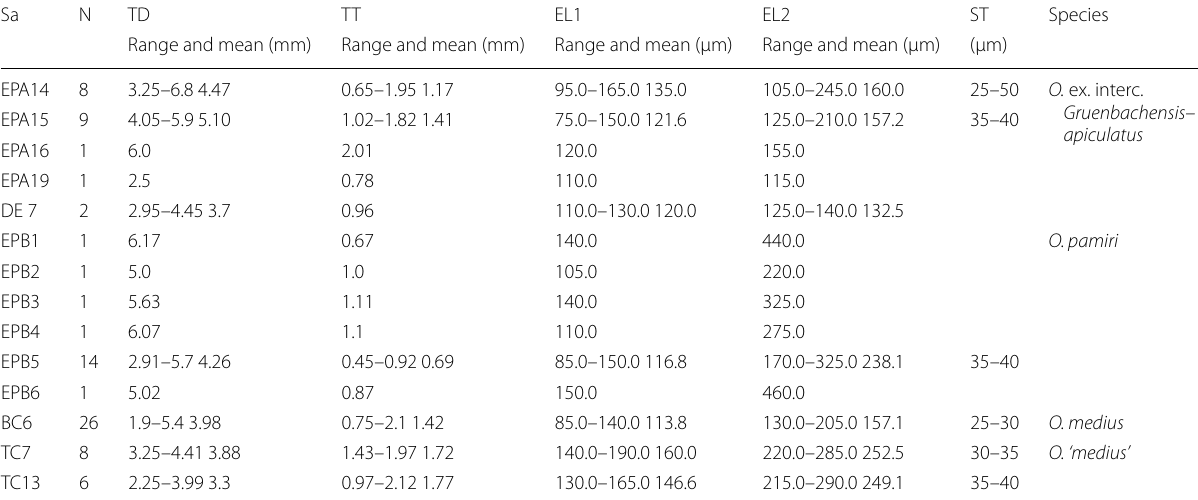
Table 2 Measurements of Orbitoides test diameter (TD) and thickness (TT), thickness of equatorial layer in nepionic stage (EL1) and near the periphery of the test (EL2) and diameter of stolons near the periphery of test (ST)